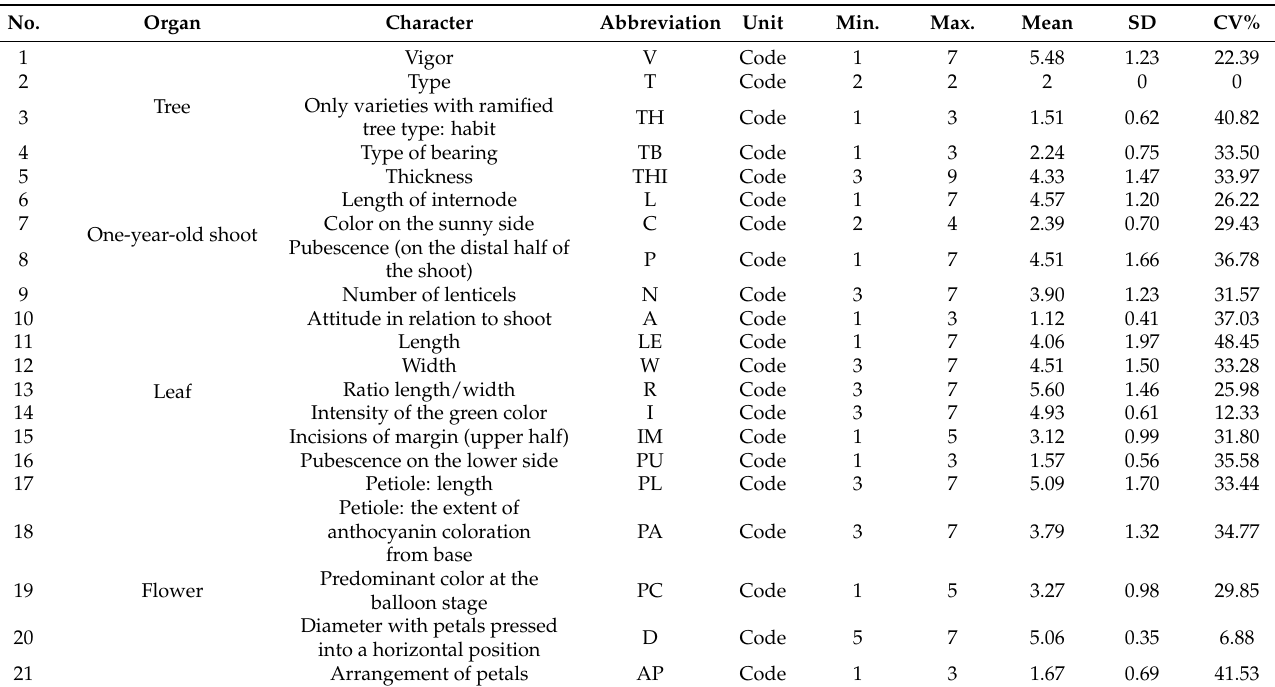
Figure 1. Geographical location of the original place of several cultivars enrolled in the inventory of Campania regional bank and the ex-situ collection of CREA-OFA (Pignataro Maggiore, Caserta Italy). Table 1. Descriptive statistics for morphological traits utilized in autochthonous apple cultivars compared to standard cultivars (‘Annurca Rossa del Sud’ and ‘Golden